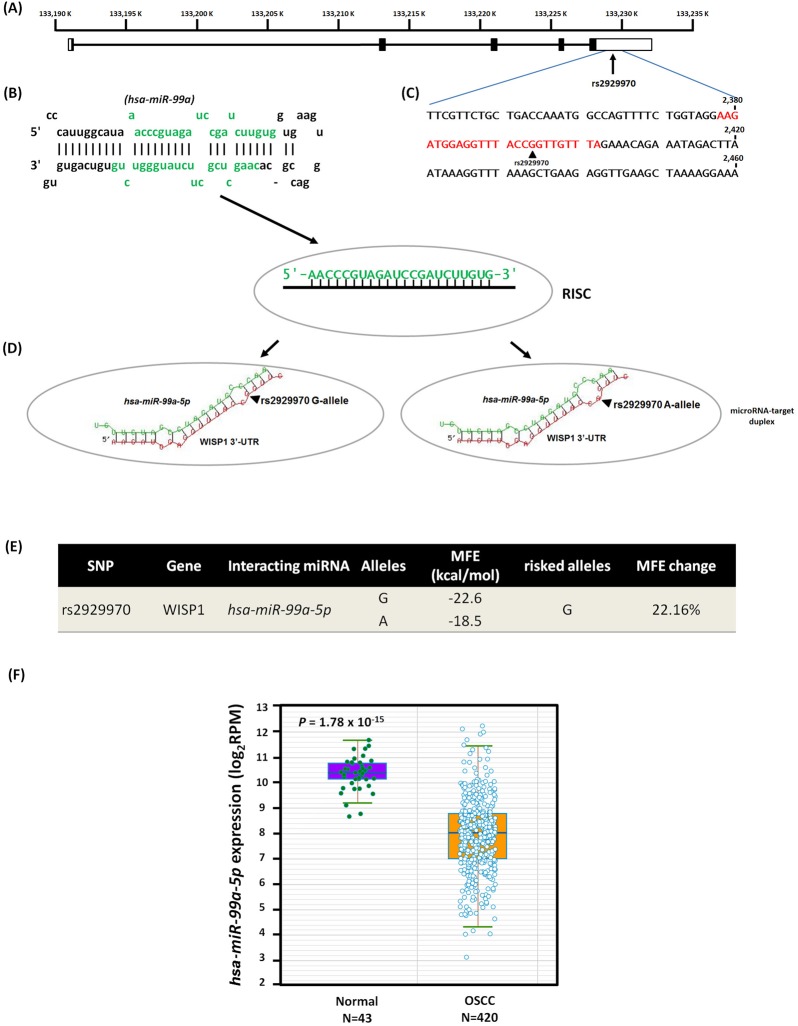
Binding site polymorphism from SNP rs2929970 [G/A] in human WISP1 3’-UTR mRNA with microRNA hsa-miR-99a-5p to decrease oral cancer susceptibility among Taiwan HNSCC population.(A) Exons of WISP1 are shown by the filled boxes from the chromosome positions (chr.13, reference genome GRCh37.p13). (B) The stem-loop portion of miRNA-miRNA duplex structure on pre-miRNAs (hsa-miR-99a; miRBase ID: MI0003190) was identified by microRNA target prediction on MicroRNA.org resource. The hsa-miR-99a-5p sequence marked by green fonts. (C) Sequence of the human WISP1 3’-UTR region and number shown the positions of mRNA (NM_003882). Predicted hsa-miR-99a-5p binding site with SNP rs2929970 was highlighted by color red fonts. (D) The models of microRNA-target duplex were determined using the RNAhybrid web tool on the Bielefeld Bioinformatics Server. RISC, RNA-induced silencing complex, arrows indicate the locus of rs2929970. (E) The SNP rs2929970 A-allele reduces the free binding energy (MFE, minimum free energy; change: 22.16%). (F) Boxplot chart counting the differential expressions of microRNA hsa-miR-99a-5p in the 420 OSCC patients and 43 normal from Pan-Cancer dataset.